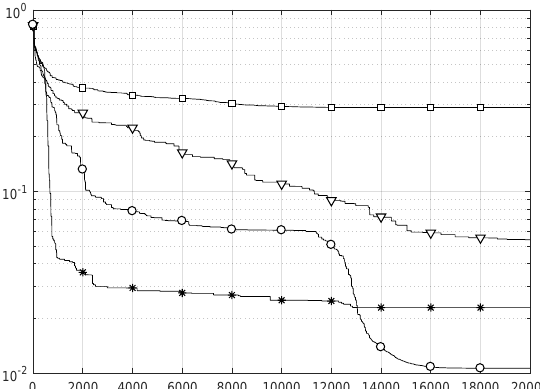
Figure 7. Average best solution (i.e., the achieved minimum, described by the y-axis) in terms of FES (the number of objective function evaluations, described by the x-axis). SSA [ (cid:3) ], STSSA [ (cid:96) ], IWSSA [ (cid:84) ], and ISSA[ ◦ ].